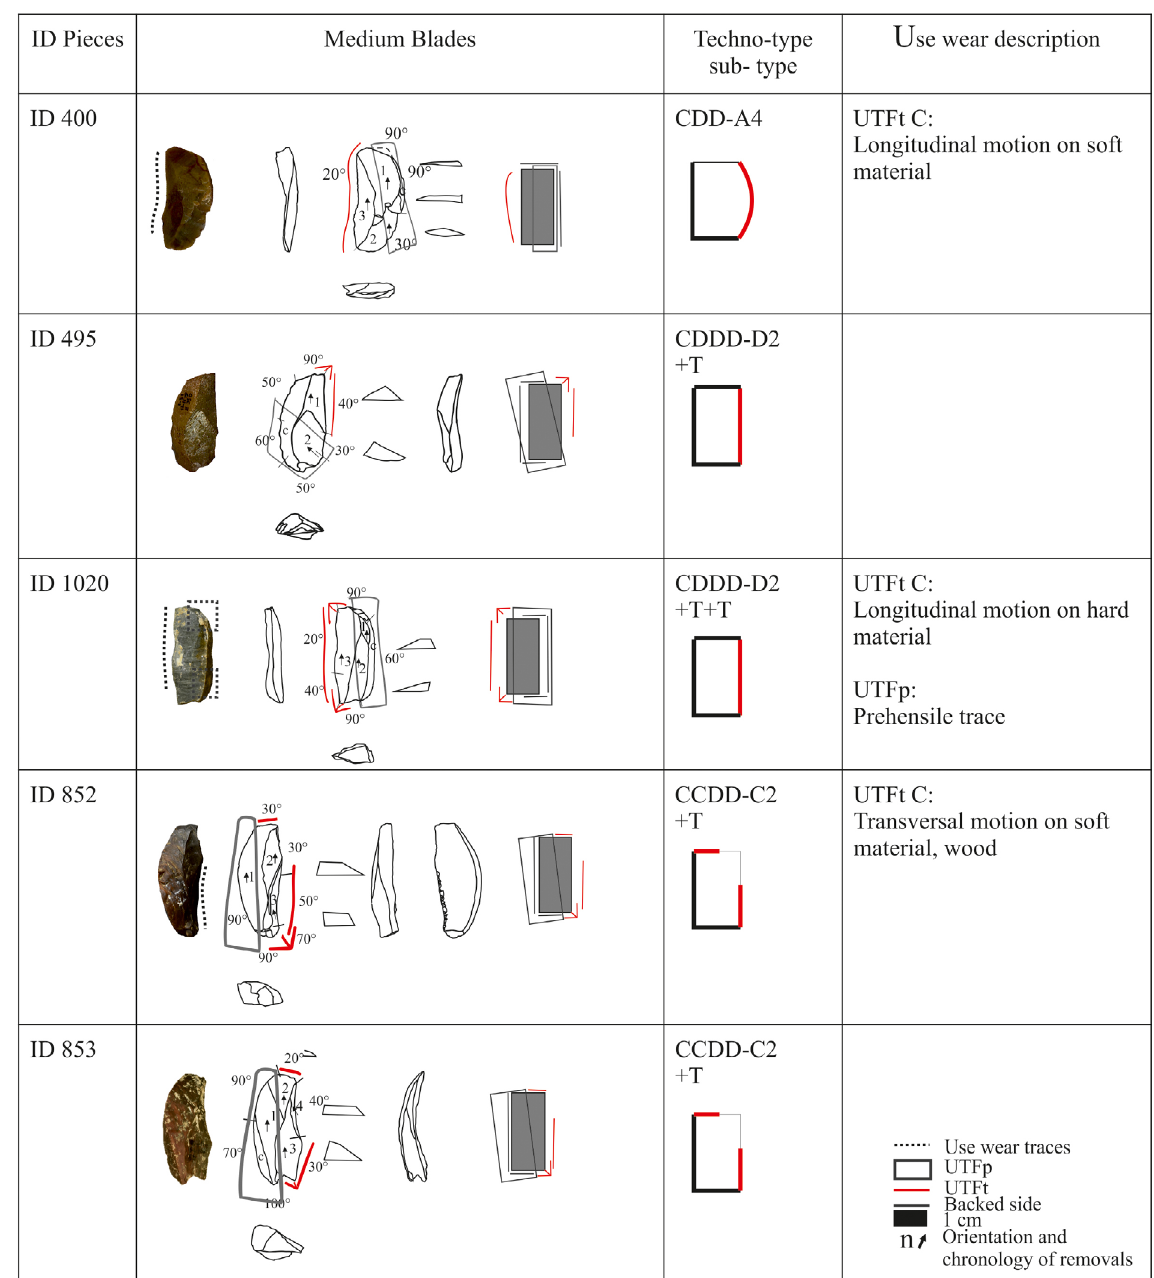
Figure 10. techno-functional analysis and description of use wear traces of the medium